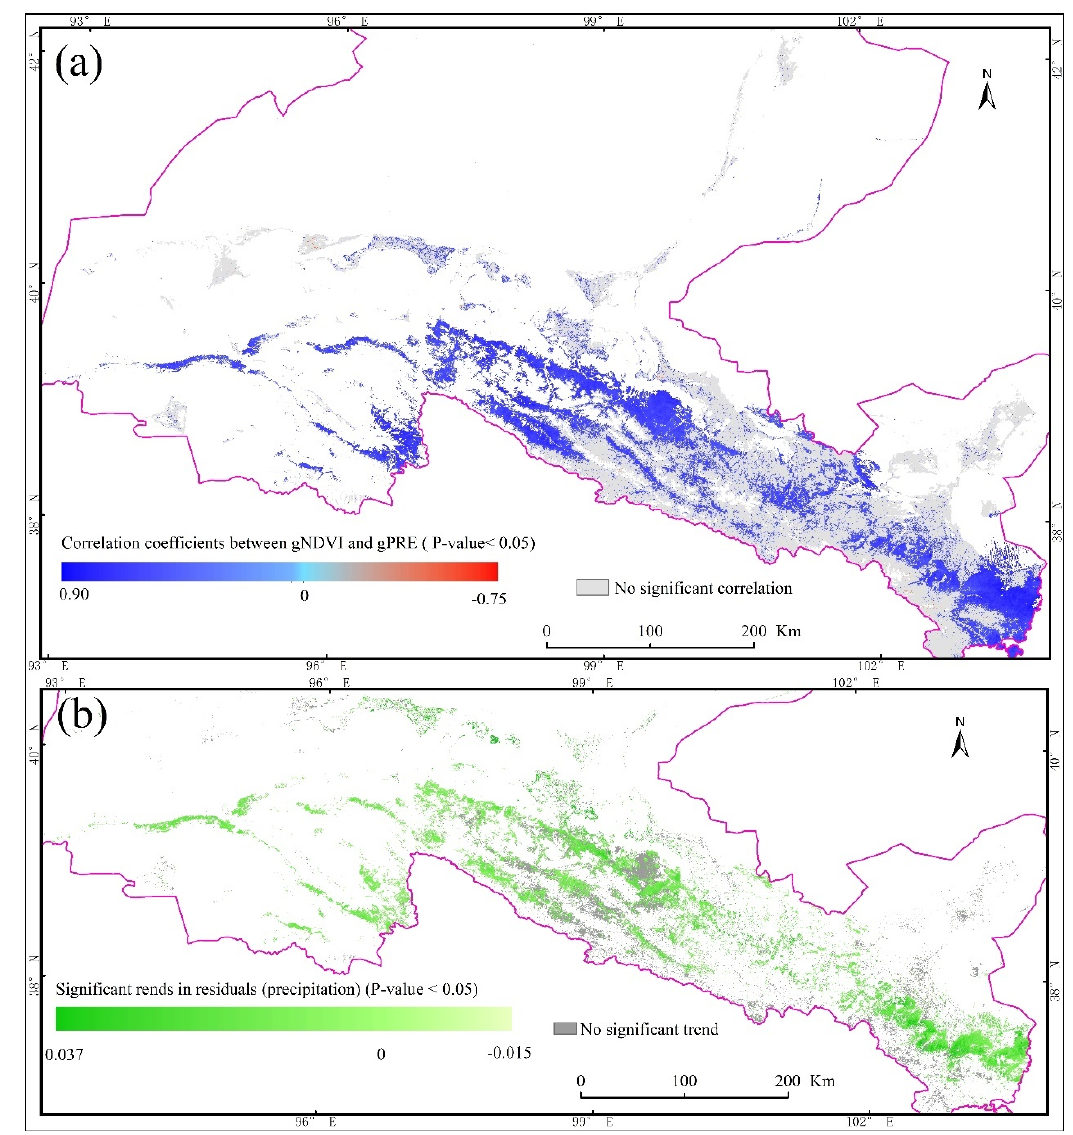
Figure 7. Correlation coefficients between gNDVI and gPRCP in the Hexi region over the period 2001 − 2017 ( a ) and trends in residuals derived from the linear regression between gNDVI and gPRCP over the period 2001 − 2017 ( b ).